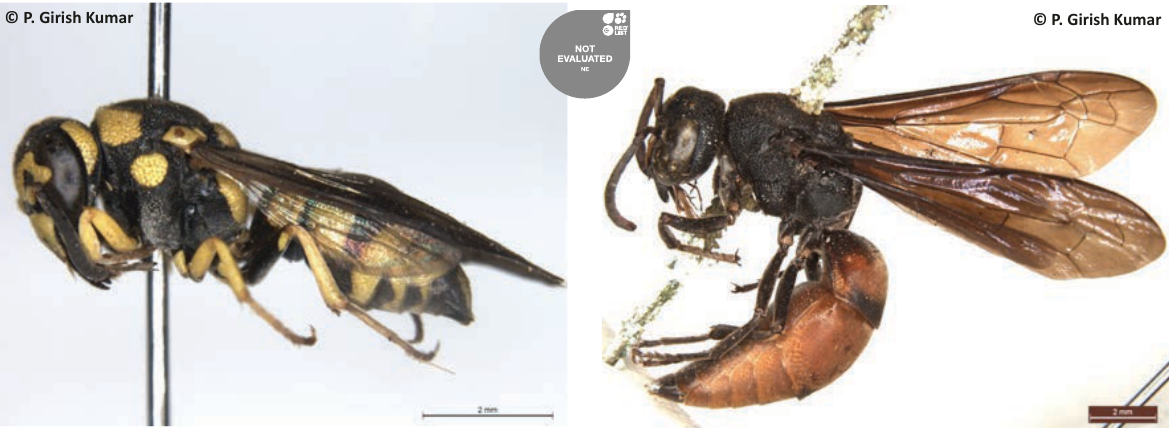
(cid:926) (cid:87)(cid:856) (cid:39)irish Kumar